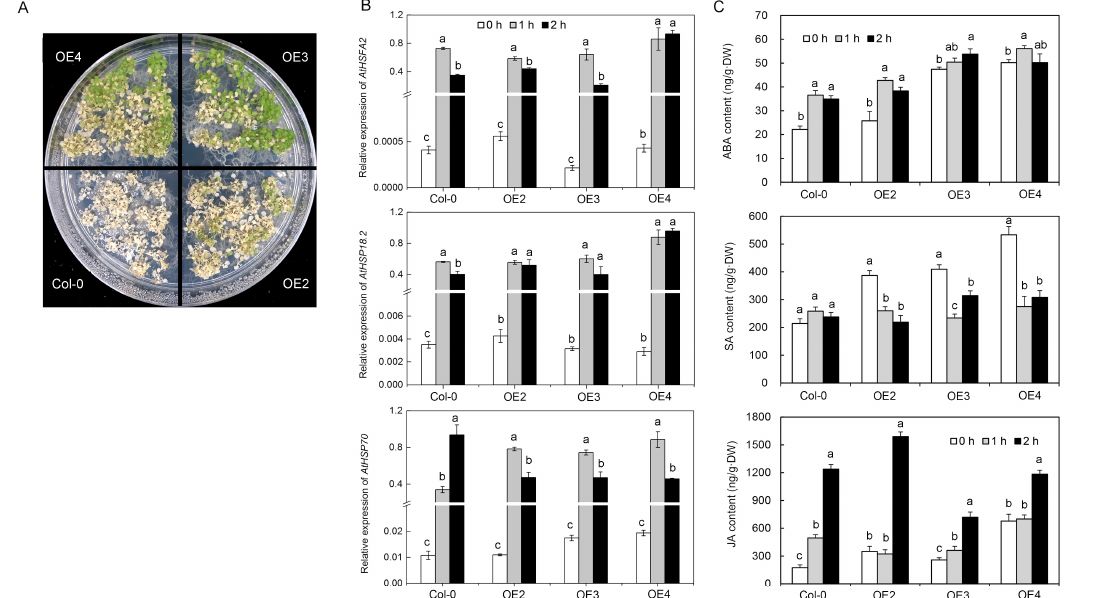
Figure 4. The effect of heterologous VvDREB2c expression and exposure to high temperature on phenotype, heat-stress-related gene expression, and hormone levels in Arabidopsis. ( A ) Phenotype. ( B ) AtHSFA2, AtHSP18.2 and AtHSP70 expression. ( C ) Hormone levels. Different letters over bars indicate significant difference in the same lines and under different treatments; p < 0.05).